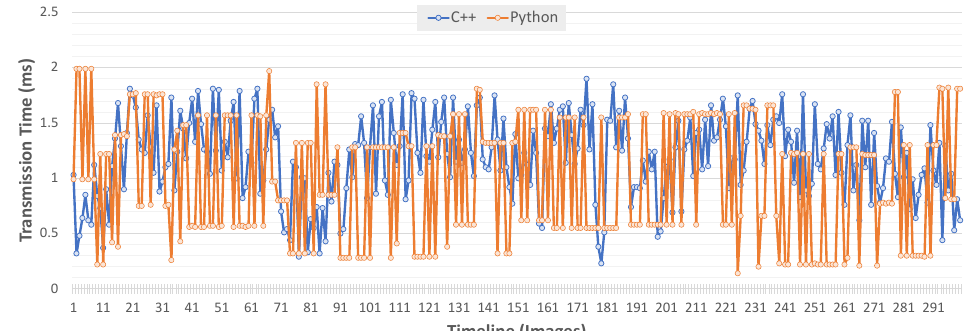
Figure 5. Data transmission times from Unity to C++ and Python. For C++ DLL: average, 1.19 ms; minimum, 0.23 ms; maximum, 1.90 ms. For Python MQTT: average, 1.01 ms; minimum, 0.14 ms; maximum, 1.99